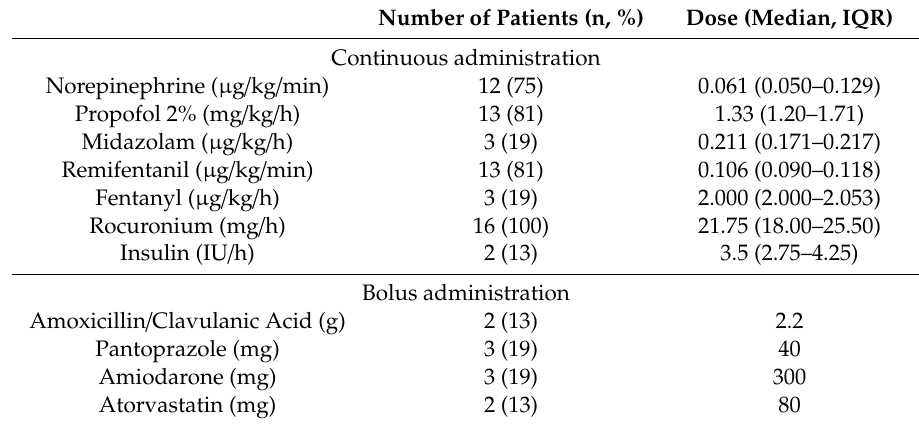
Figure 3. Rate of high platelet reactivity (HPR) after end of cangrelor infusion. Minutes 30 to 1440 refer to the time after cangrelor cessation. Cangrelor sufficiently inhibited P2Y12 at the time of stent placement (stent) in 100% of patients. After cangrelor cessation, the rate of HPR increased from 20% at 30 min to 44% at 90 min, and was still present in 20% of patients at 240 min. Table 2. Co-administered drugs at the time of transition from cangrelor to ticagrelor. Data are n (%) and median (25 to 75% IQR).